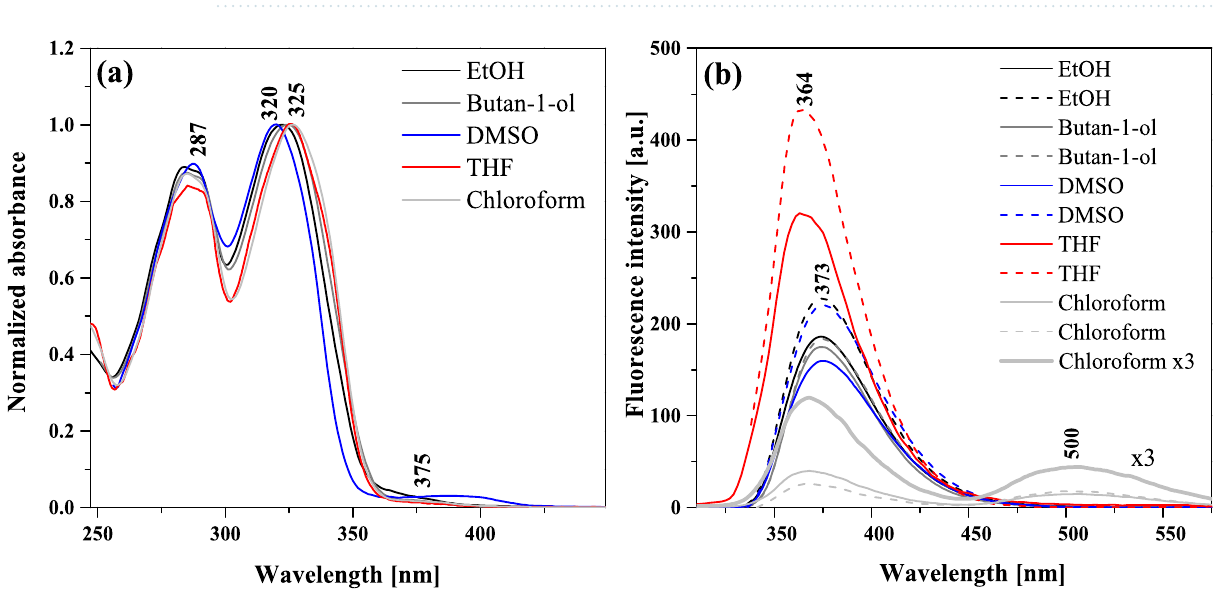
Figure 4. Normalized electronic absorption spectra (panel a ) and fluorescence emission spectra (panel b ) measured for NTBD in various solvents. The excitation wavelengths were 285 nm (solid line) and 325 nm (dotted line). Chloroform × 3 means the fluorescence intensity was multiplied by 3 for a better representation of the spectrum measured for NTBD in